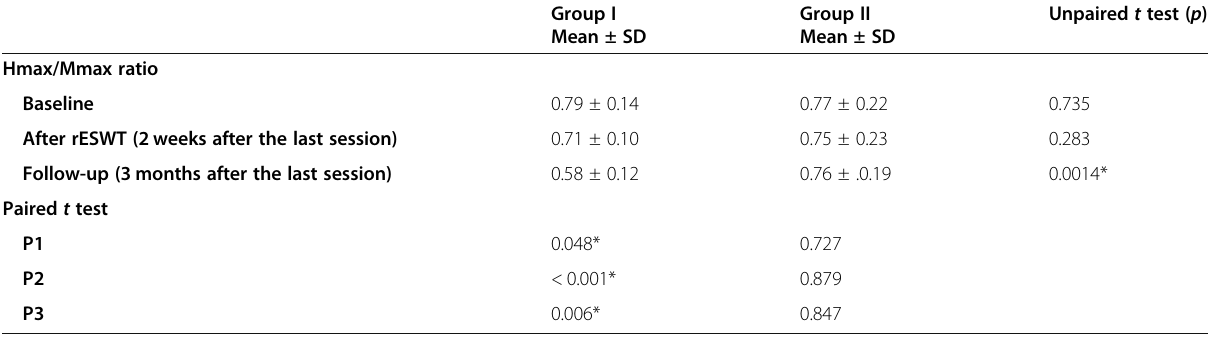
Table 4 Hmax/Mmax ratio in the studied groups at baseline, after rESWT, and at follow-up showing a significant decrease of Hmax/ Mmax ratio in GI after rESWT therapy relative to baseline and significant improvement in comparison to GII at follow-up